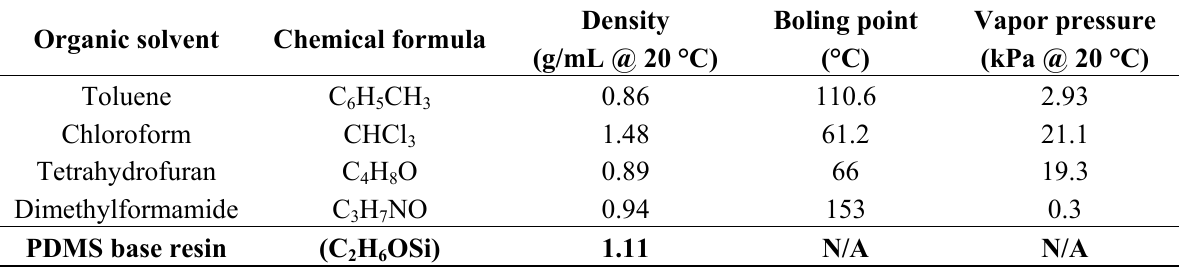
Table 1. Important properties of experimentally tested organic solvents.